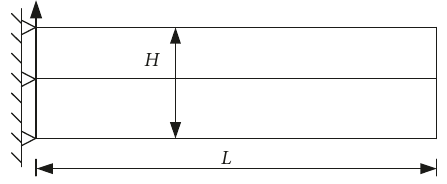
Figure 28: Cantilever